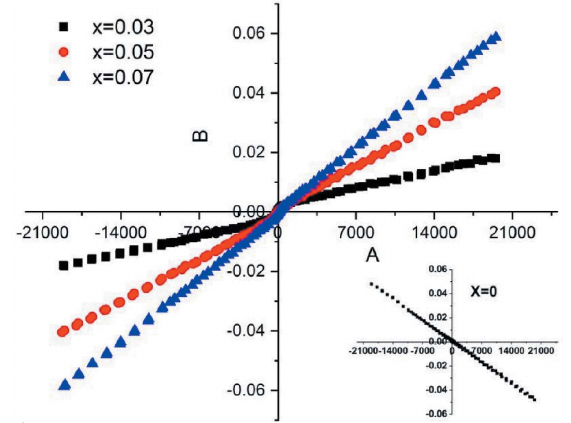
Figure 11 Room-temperature M – H loops of Mn-doped ZnO NPs ( x = 0.0, 0.03, 0.05 and 0.07